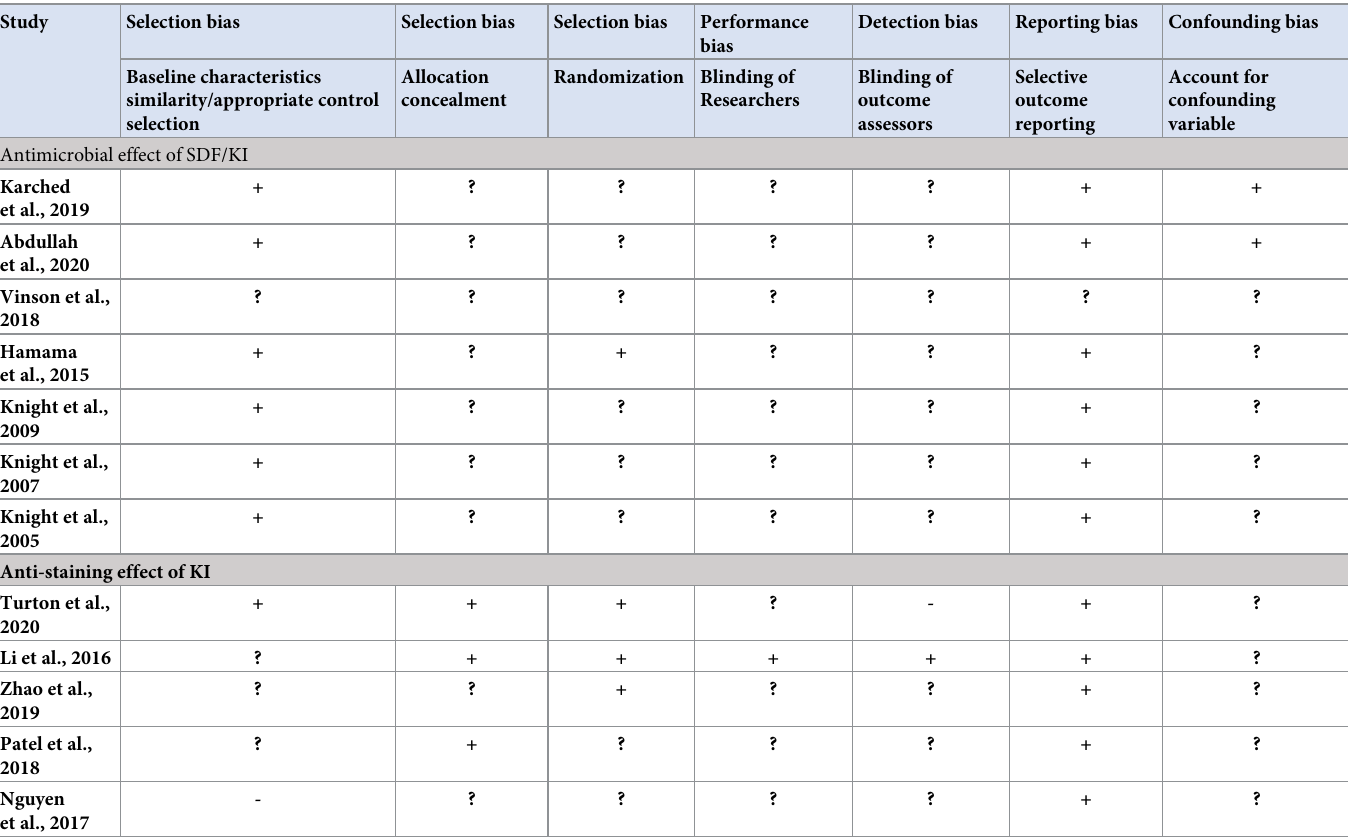
Table 3. Risk of bias of the included